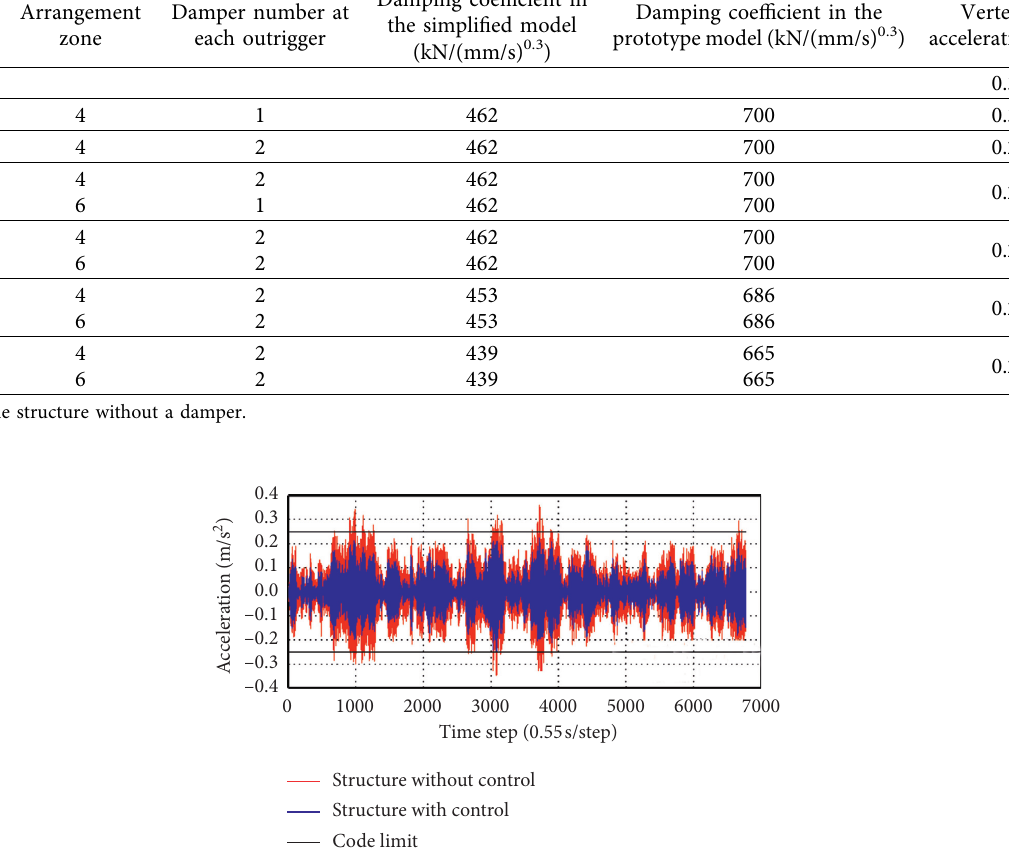
Figure 25: Comparison of the structure vertex acceleration with and without damped outriggers.